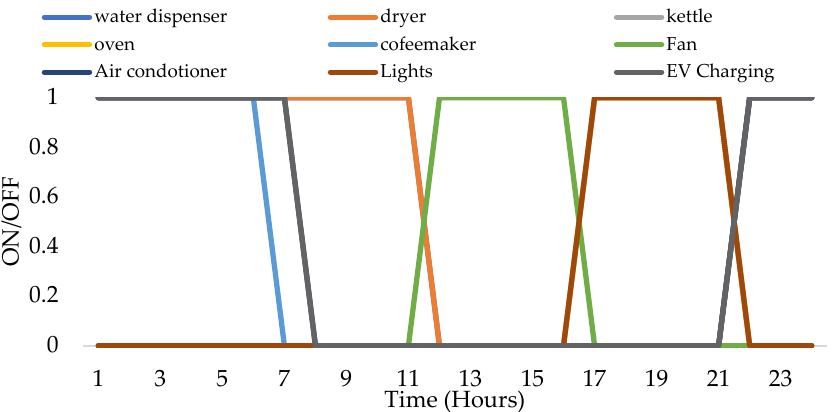
Figure 20. Individual power of home appliances.